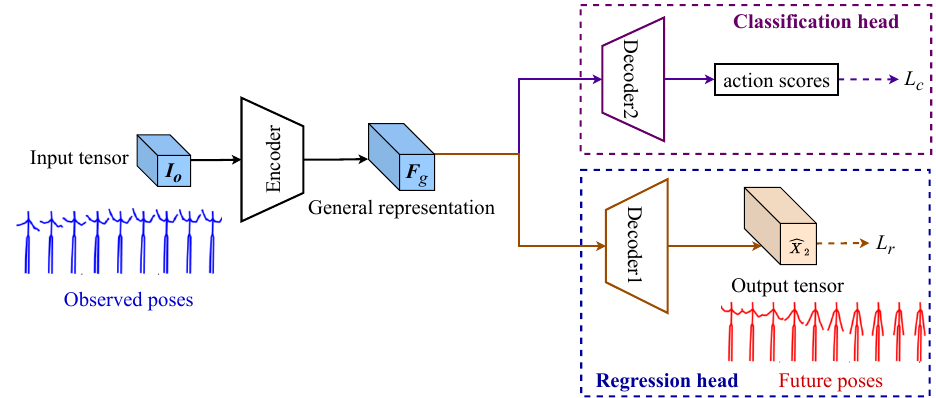
Figure 3. The architecture of the Multi-head TrajectoryCNN.